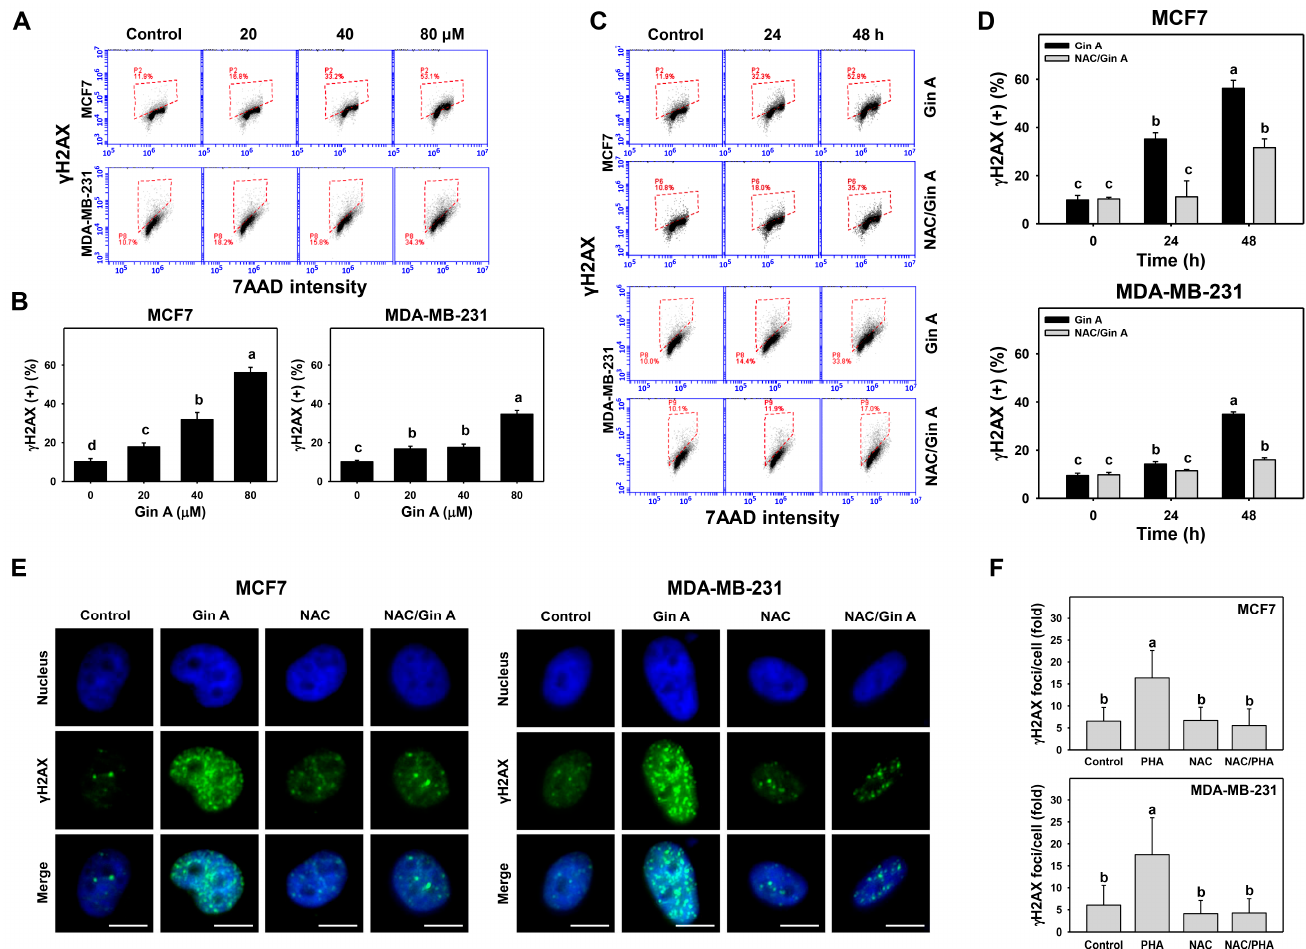
Figure 7. Impact of Gin A on γ H2AX level and foci of breast cancer cells. ( A , B ) γ H2AX level. Cells were treated with 0 (0.1% DMSO; control), 20, 40, and 80 µ M Gin A for 48 h. Subsequently, they were subjected to γ H2AX flow cytometry. Red boxes indicate γ H2AX (+) populations. ( C , D ) NAC reverted effects on γ H2AX level. Cells were pretreated with NAC (10 mM) for 1 h and then post-treated with Gin A (control and 80 µ M) for 0, 24, and 48 h, namely NAC/Gin A. Data, means ± SDs ( n = 3). When the connecting letters are overlapping, this means that their difference was significant for multiple comparisons ( p < 0.0001). For the example of MCF7 cells ( D ), Gin A at 0, 24, and 48 h showing c , b , and a differs significantly. NAC/Gin A at 24 and 48 h showing c and b differs significantly, whereas Gin A and NAC/Gin A at 0 and 24 h showing the overlapping letter c differ non-significantly. ( E ) Fluorescence analysis for γ H2AX foci. Cells were stained by the senescence-detecting probe and counterstained with Hoechst 33342. Slides were photographed at 400× magnification. Scale bar = 10 μ m. DNA damage was counted as γ H2AX foci per cell. Data, means ± SDs ( n = 20 cells).